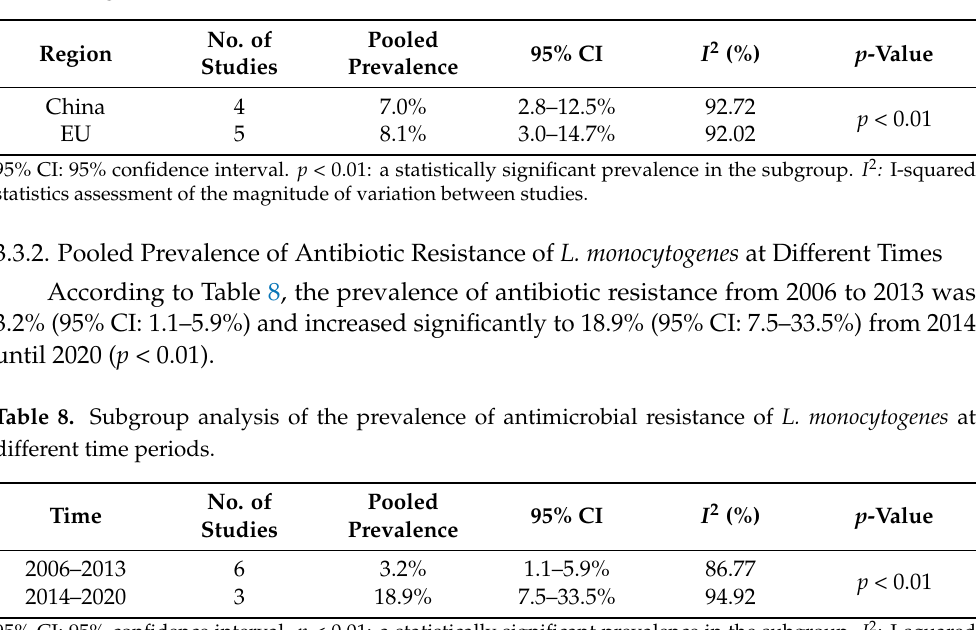
Table 7. Subgroup analysis of the prevalence of antimicrobial resistance of L. monocytogenes in different regions.